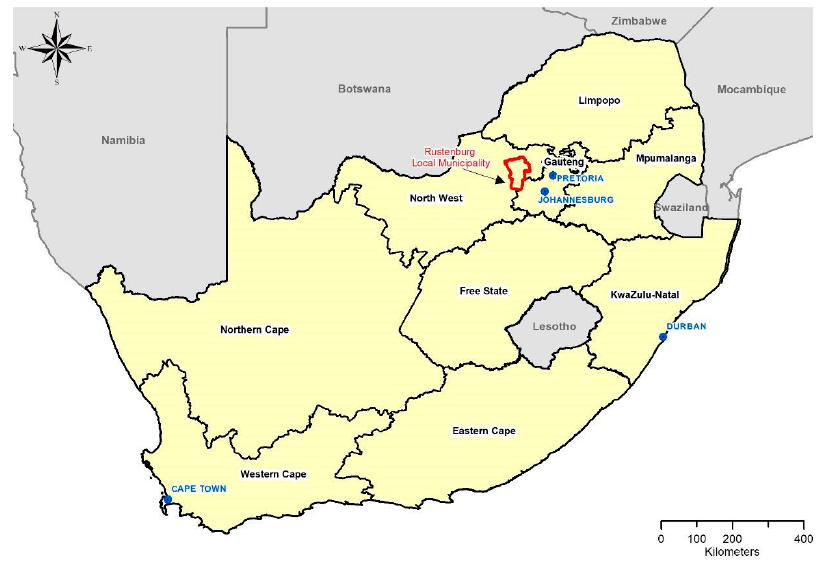
Figure 1. Location of Rustenburg Local Municipality in the North-West province of South Africa.